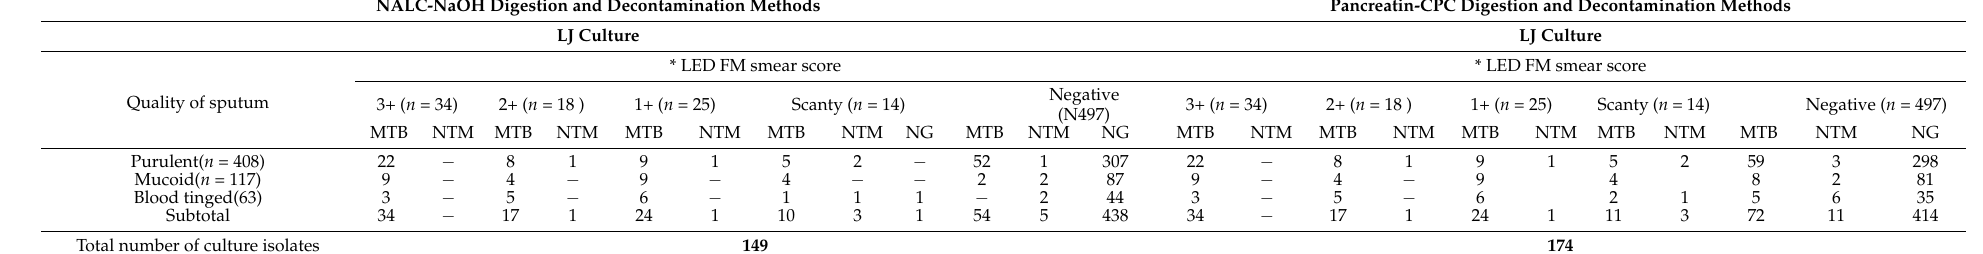
Table 2. Comparison of isolation rates of MTB and NTM using LJ culture (after pretreatment with NALC-NaOH DDM and Pancreatin-CPC DDM) as demonstrated by LED-FM smear scores and quality of sputum.